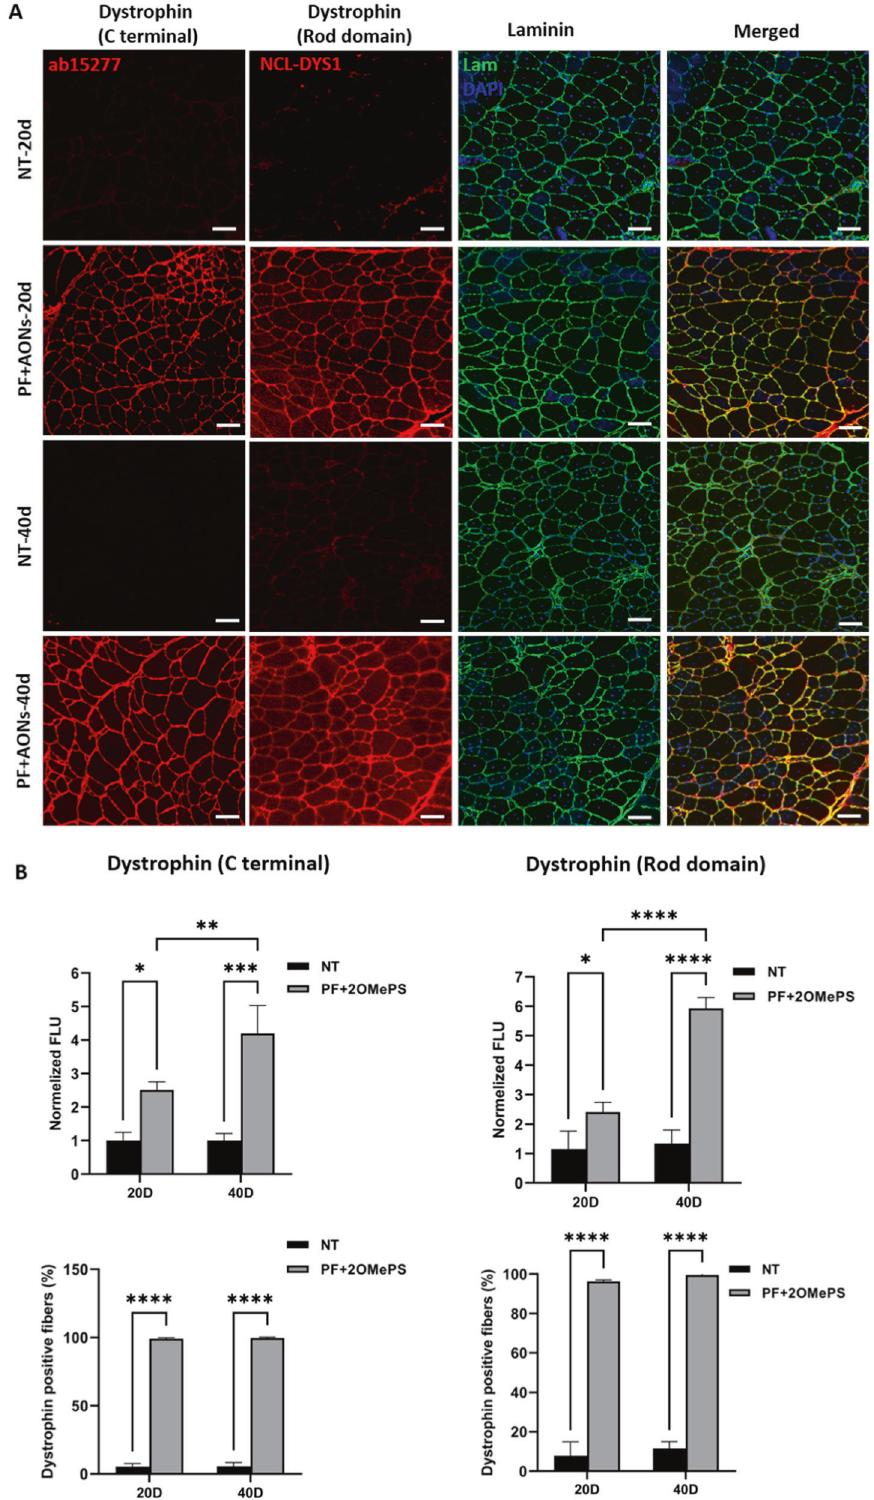
Fig. 6 Dystrophin expression of TA muscles after intra-femoral (IF) injection. A Immunohistochemical staining of dystrophin (red) detected using ab15277 (C-term) and NCL- Dys1(Rod domain) 20 and 40 days post-Intra-femoral injection of 2OMePS/PEI loaded PF microspheres in mdx mice, compared to non-treated (NT) mdx mice at the same time points. Sections were counterstained for laminin to detect the sarcolemma (green), and DAPI to detect the nuclei (blue). Representative images are shown; scale bar = 50 μ m. B Quantitative fl uorescence intensity of 2OMePS/PEI loaded PF microsphere treatment normalized to non-treated (NT) mdx mice for the TA cryosections stained for dystrophin C-terminal region (ab15277) and ROD domain (NCL-DYS1). Quantitative data ( n = 3) is presented as mean ± SD; **** P < 0.0001, *** P = 0.0001, ** P = 0.0091, * P = 0.0169 compared to NT mdx mice. Also shown is the percentage of dystrophin-positive fi bers in 2OMePS/PEI loaded PF microsphere treatment at 20 and 40 days post-Intra-femoral injection of mdx mice, compared to non-treated (NT) mdx mice. Quantitative data ( n = 6) is presented as mean ± SD; **** P < 0.0001 compared to NT mdx mice. Cell Death and Disease (2022)